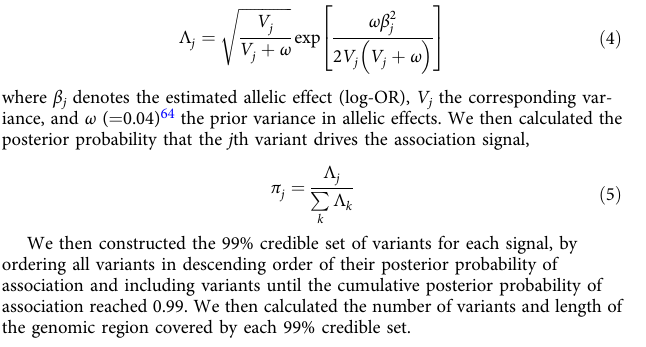
Statistical analysis . Statistical analyses for association studies between RSPO3 SNVs and OBB quantitative traits were performed using PLINK v.1.07 (pngu.mgh. harvard.edu/~purcell/plink/). All quantitative traits were log transformed and analysed with an additive linear regression model adjusting a priori for age, sex and % total fat mass. All other statistical analyses were performed using SPSS 22, SigmaPlot 14.0 or GraphPad 7.04. Evidence for between-group differences were assessed using a two-tailed paired or unpaired Student ’ s t -test, as appropriate, unless otherwise speci fi